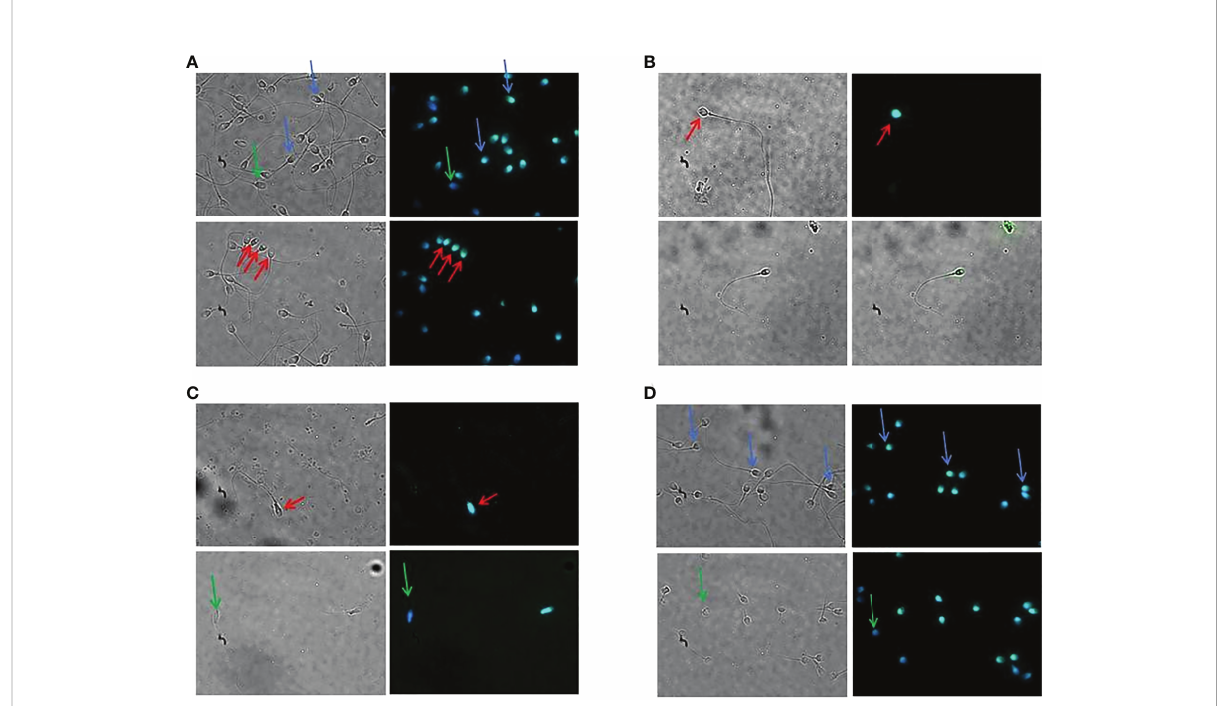
FIGURE 2 Immunolocalization of the IGF2 protein in human spermatozoa. Immuno fl uorescence analysis of spermatozoa of patients 1 (A) , 2 (B) , 3 (C) , and 4 (D) . The protein showed a cytoplasmic, equatorial, and post-acrosomal localization (red arrows). Green arrows indicate spermatozoa lacking IGF2 protein. Blue arrows indicate a different degree of immuno fl uorescence in different spermatozoa of the same patient. Magni fi cation 100x.